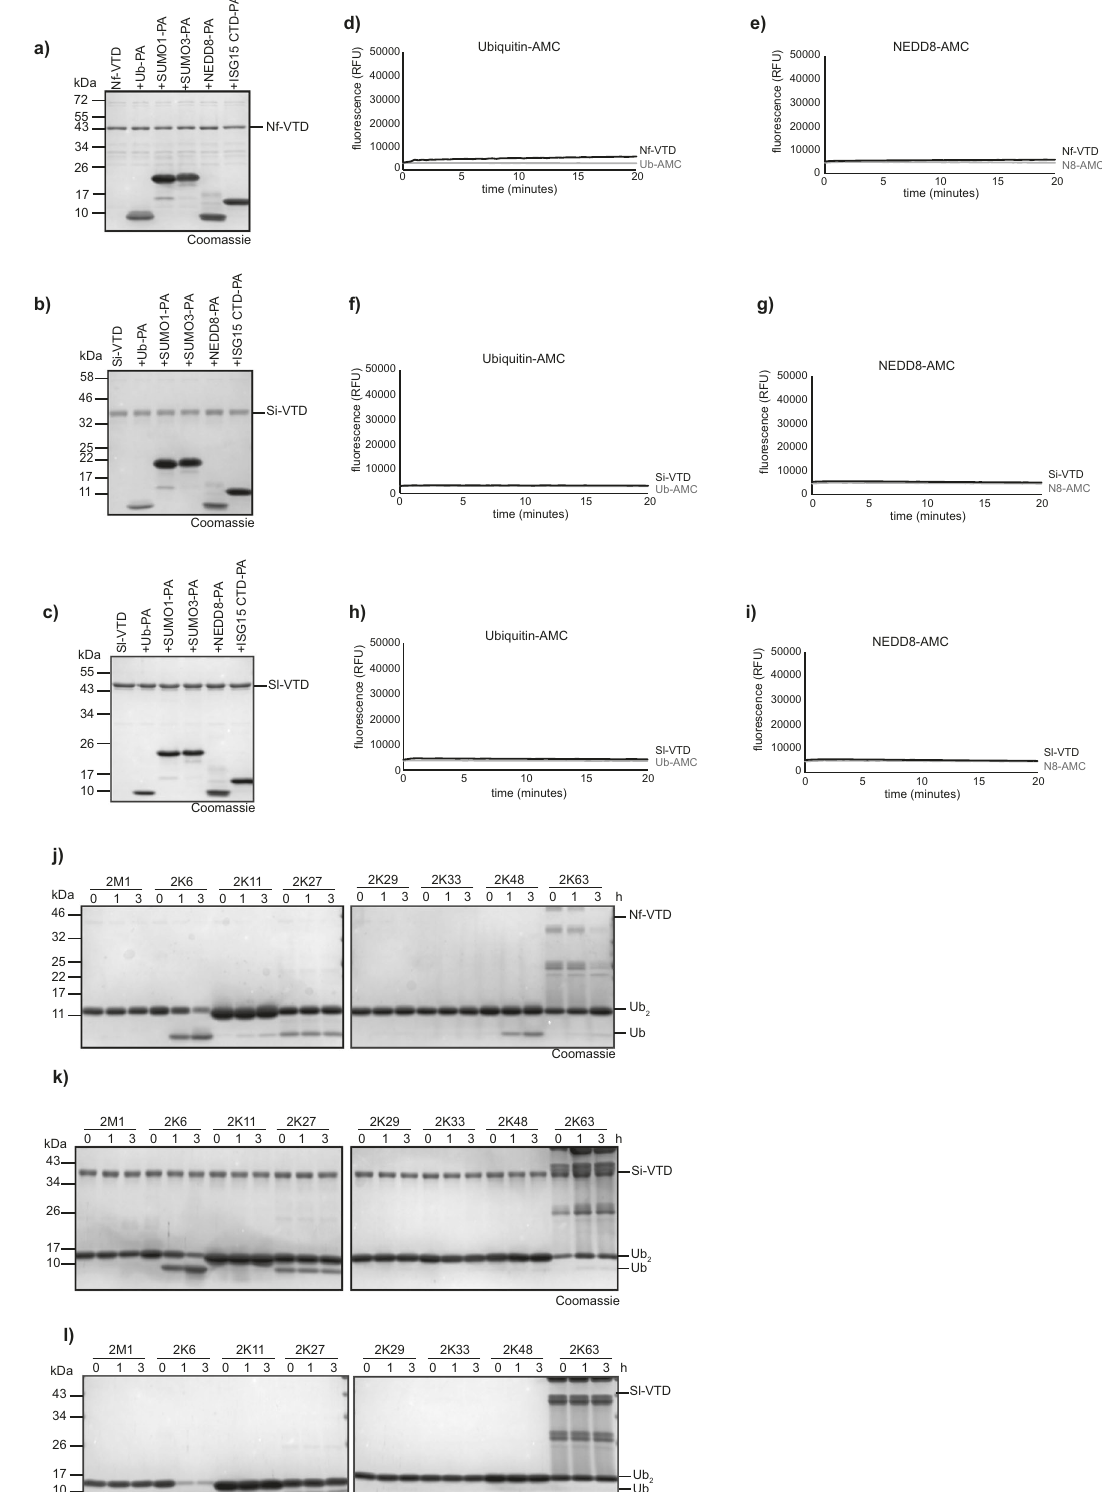
Fig.6|ActivityoffungalandprotozoanVTDs.a – c ReactionofNf-VTD( a ),Si-VTD ( b ) or Sl-VTD ( c ) with Ub and Ubl activity-based probes. d , e Activity of Nf-VTD against Ubiquitin-AMC ( d ) and NEDD8-AMC ( e ). The RFU values are the means of triplicates. f , g Activity of Si-VTD against Ubiquitin-AMC ( f ) and NEDD8-AMC ( g ). TheRFUvaluesarethemeansoftriplicates. h , i ActivityofSl-VTDagainstUbiquitin-